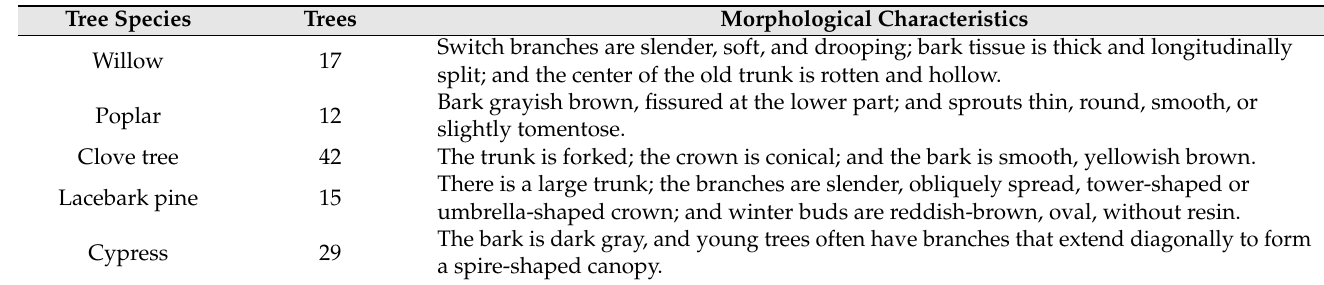
Table 1. Tree species and morphological characteristics from the study area.